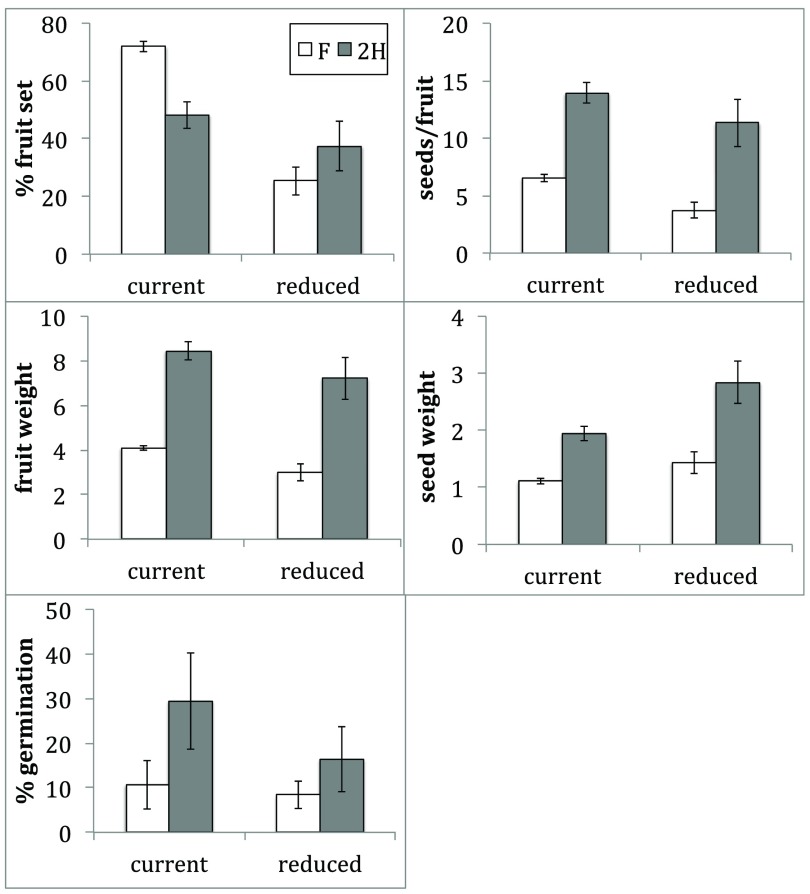
Reproductive output measures for female plants (white) and two times that of hermaphrodite plants (grey) under current and reduced pollination regimes (p < 0.05).± 1 standard error bars shown.